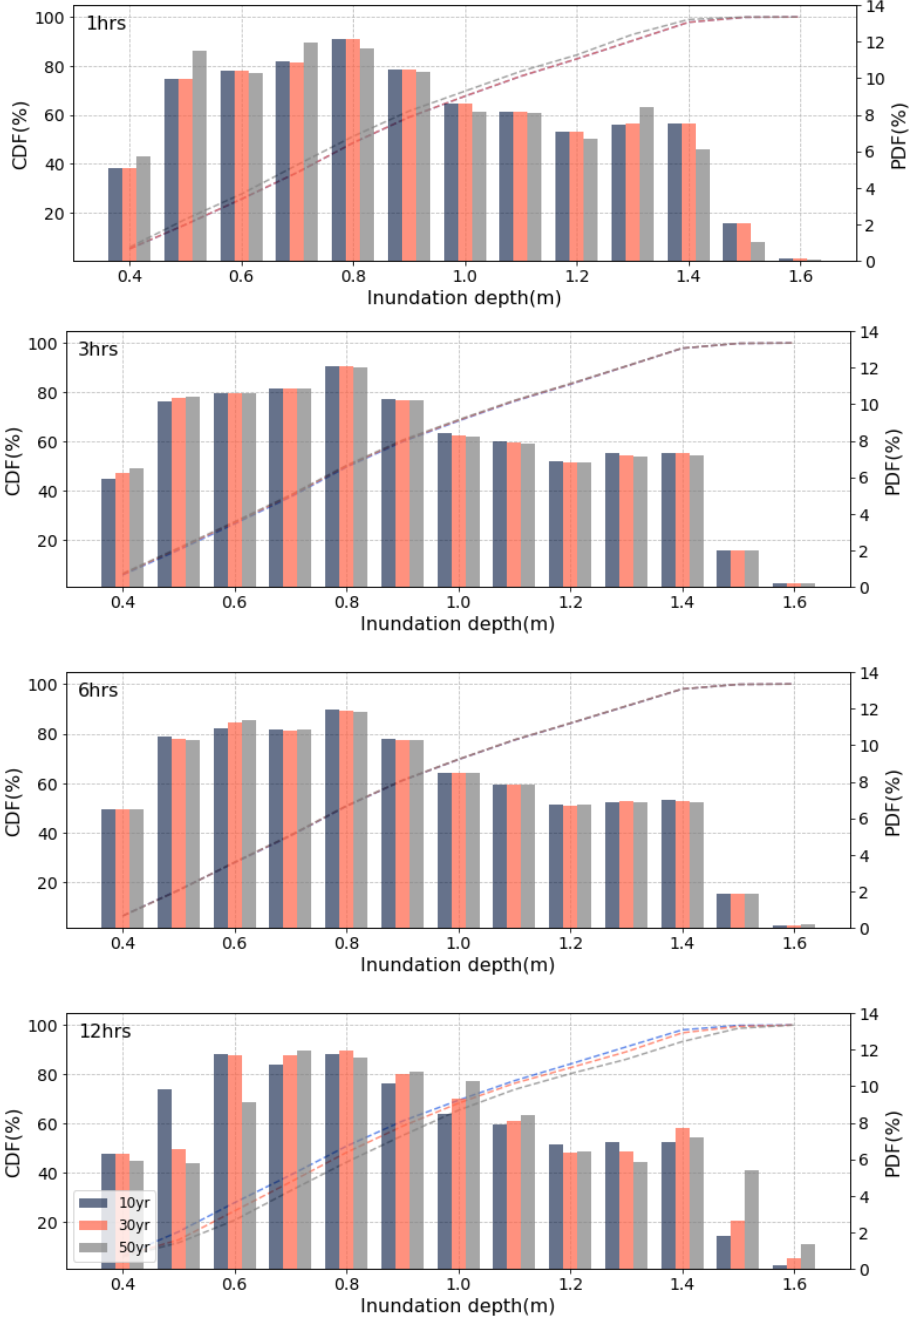
Figure 5. PDF and CDF of simulated inundation depth for a current condition.